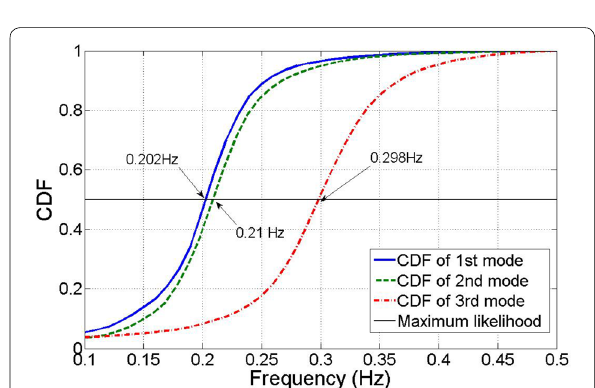
Fig. 19 Cumulative distribution function of time‑varying natural